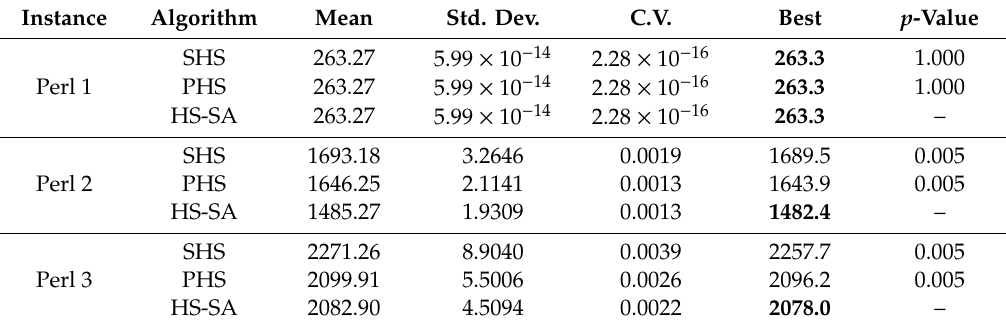
Table 6. Comparative results of Perl dataset in LIRP for SHS, PHS, and HS-SA.